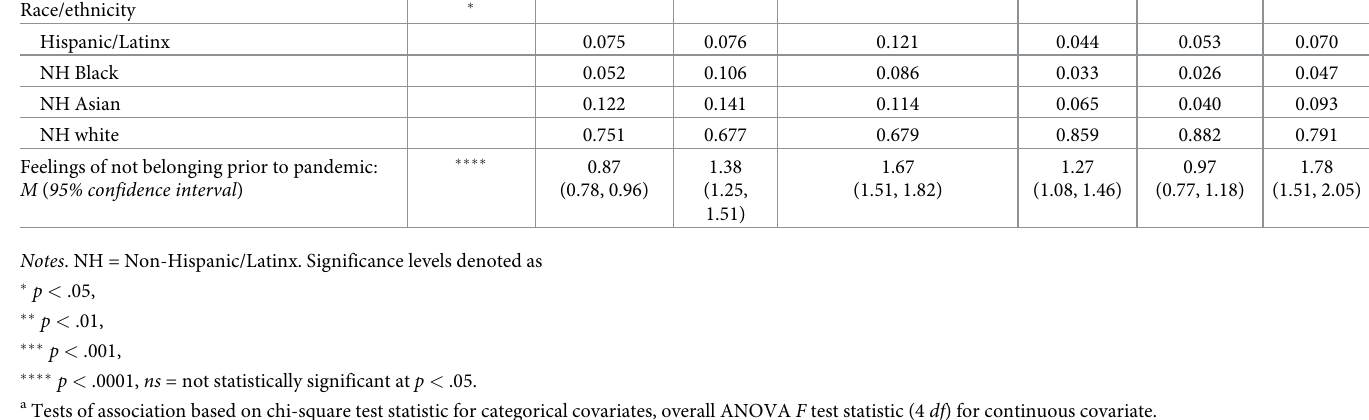
Partiers (Alcohol,